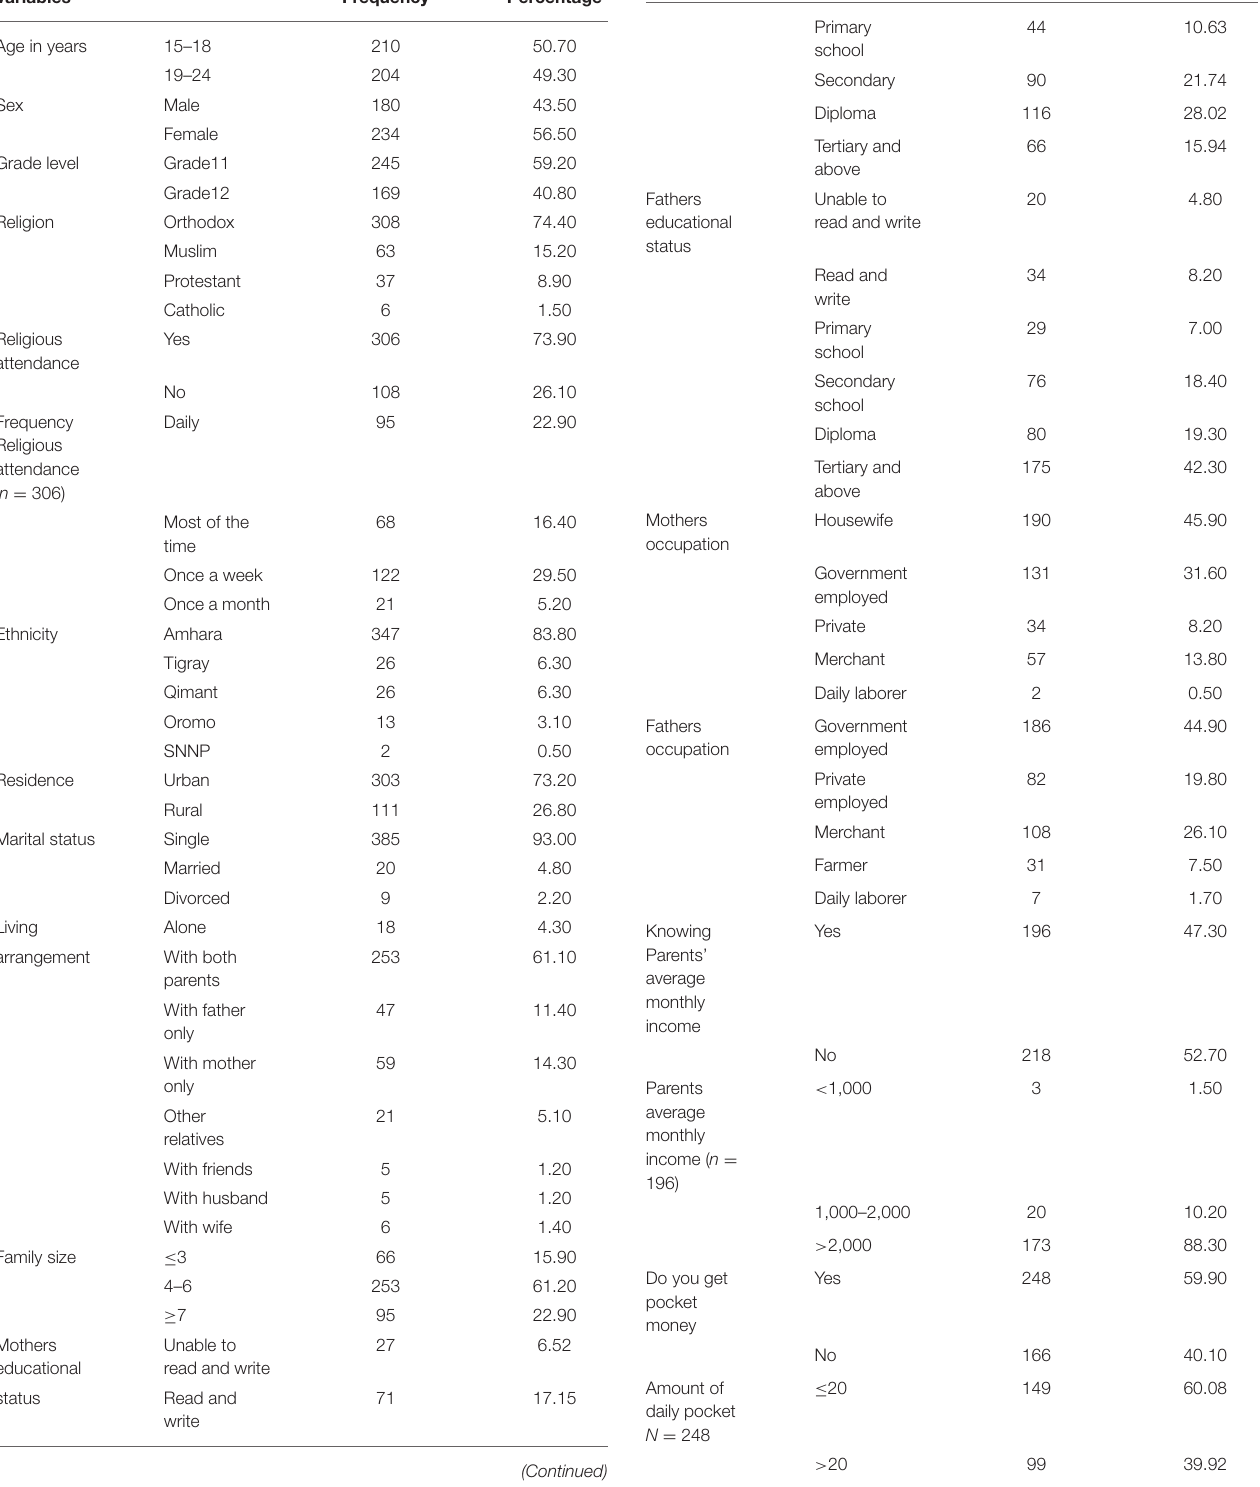
TABLE 1 | Sociodemographic characteristics of study participants and their parents in Gondar city, Northwest Ethiopia, 2019 ( n = 414).